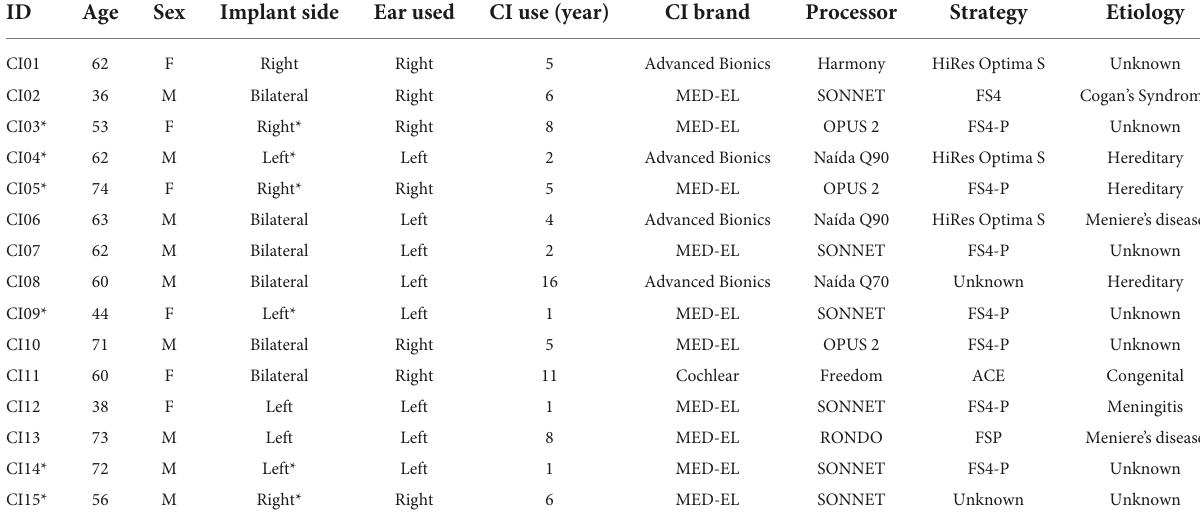
TABLE 1 Demographics of cochlear implant listeners included in the current